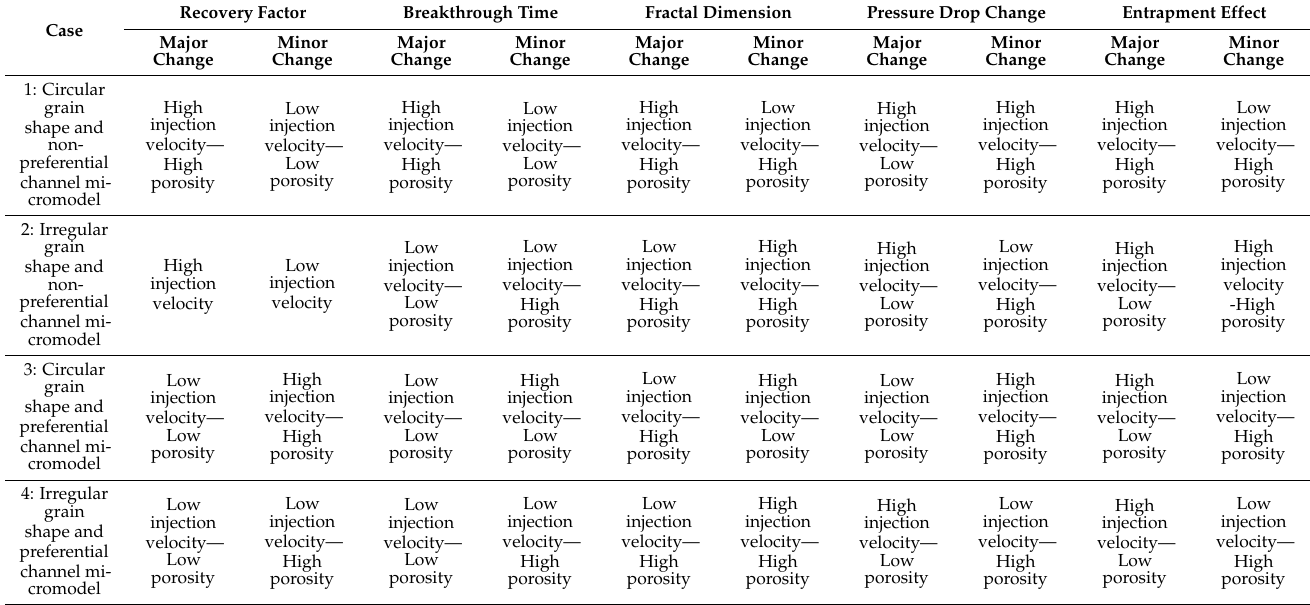
Table 7. Conditions of injection velocity and porosity that yield the highest values of χ i,IFT